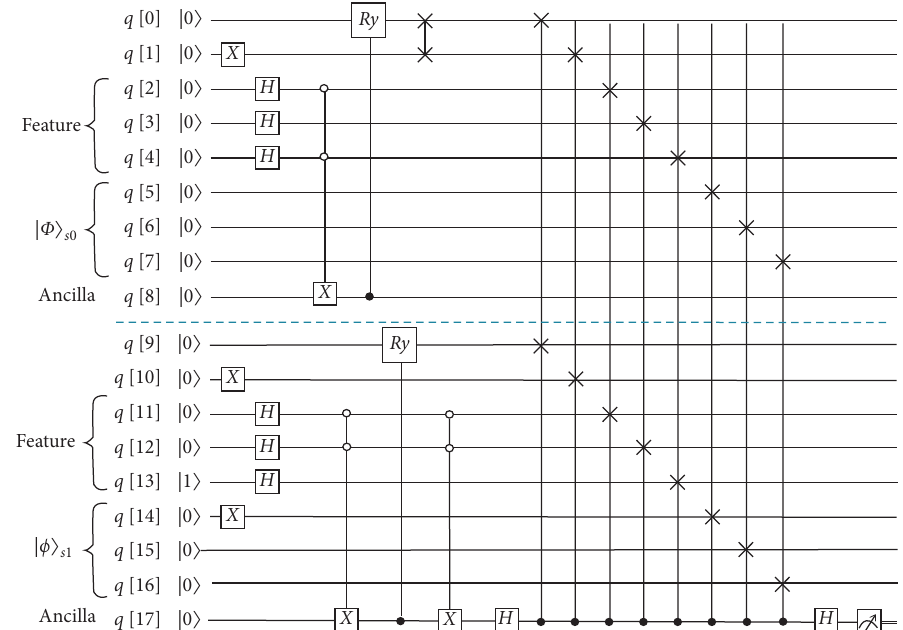
, q [9] − q [16] represents | ϕ 〉 S , and q [17] is the resultant qubit. X is the Not operation, 0 1